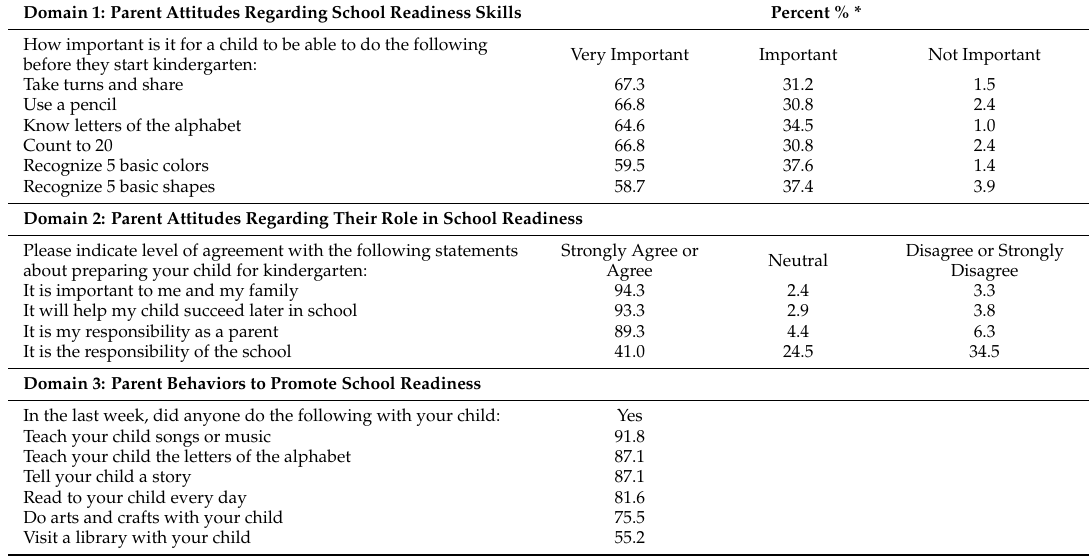
Table 1. Parent attitudes and behaviors regarding school readiness of their preschool aged children (n = 210).